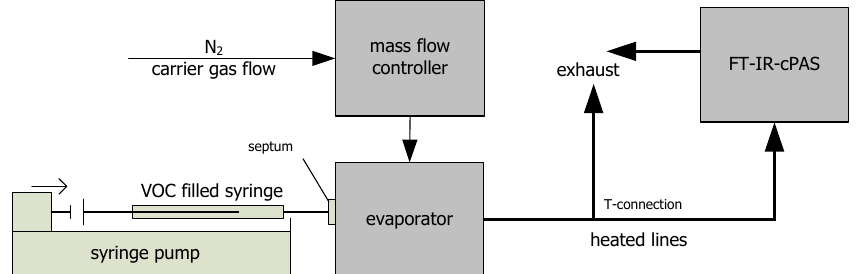
Figure 1. Schematic set up of the VOC vapor